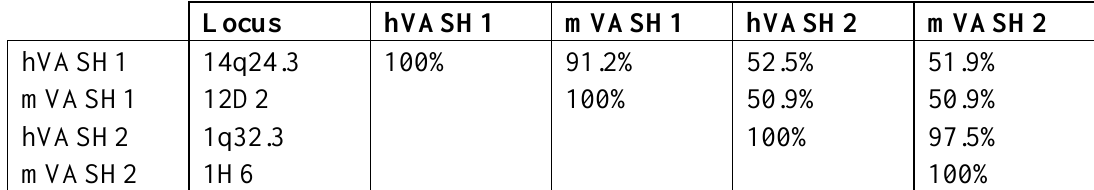
Table 1. Locus and similarity between human and mouse